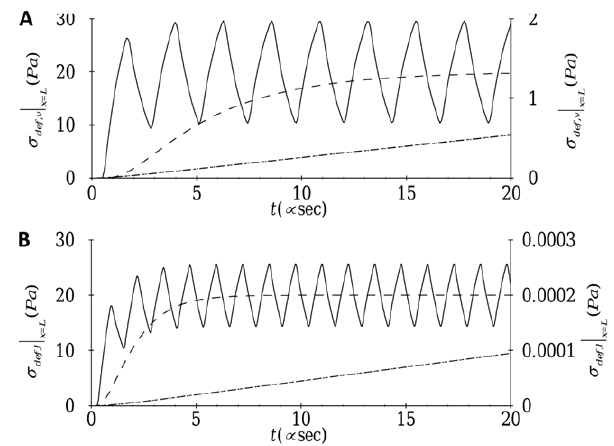
Figure 9. Time trace of the deformation-related stress at the nucleus ( x ~ L ). (A) Stress in the transverse direction ( s def , v D x ~ L ) with only the reference prestress ( s p ~ 3 | 10 5 Pa , E ~ 0 ): ––––, without cytosolic or material viscosity ( n ~ 0 , c ~ 0 ); - - - -, with only